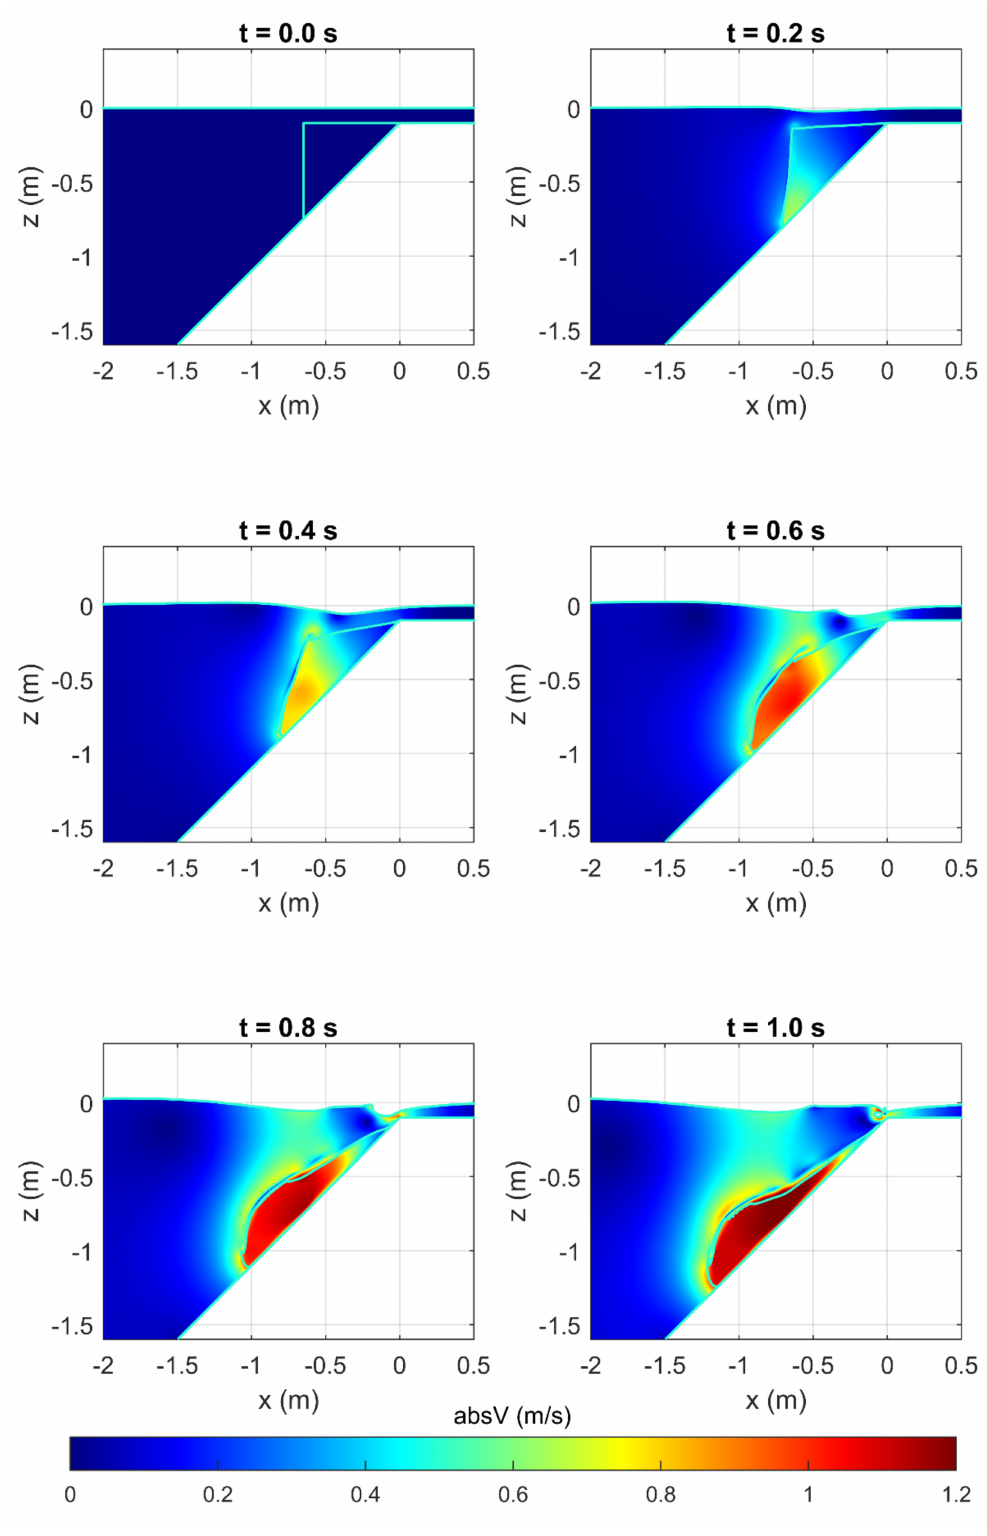
Figure 3. The snapshots of the velocity magnitude of the slump and the ambient